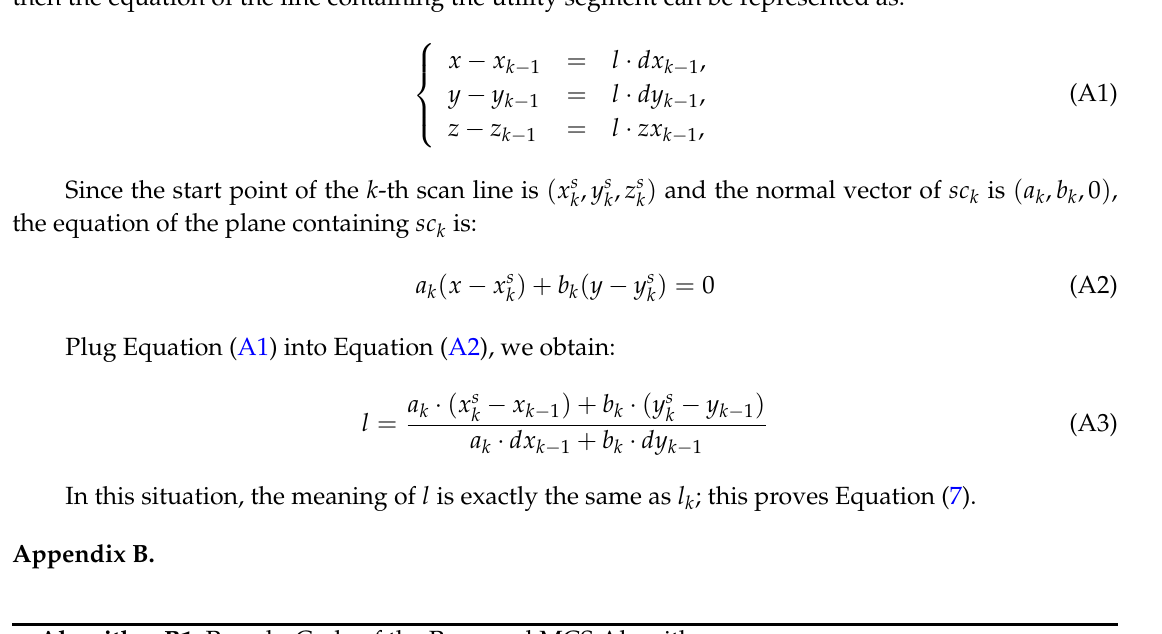
Algorithm B1: Pseudo-Code of the Proposed MCS Algorithm for each marching direction